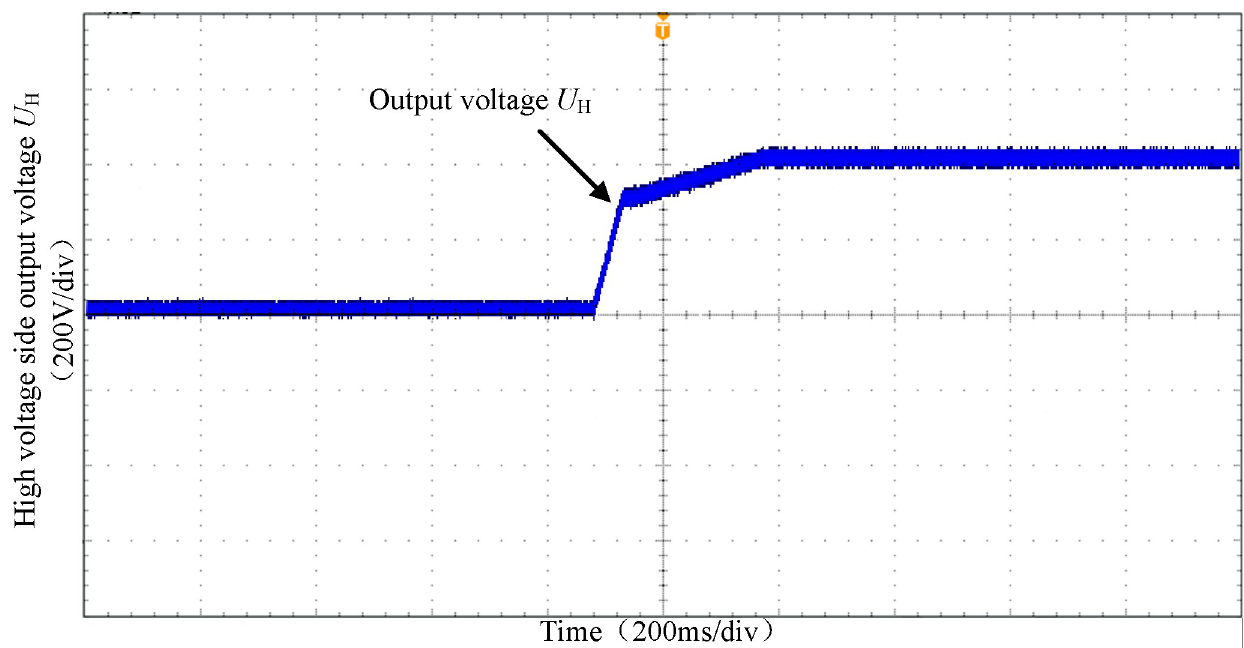
Fig 29. The output voltage waveform of the high-voltage side.